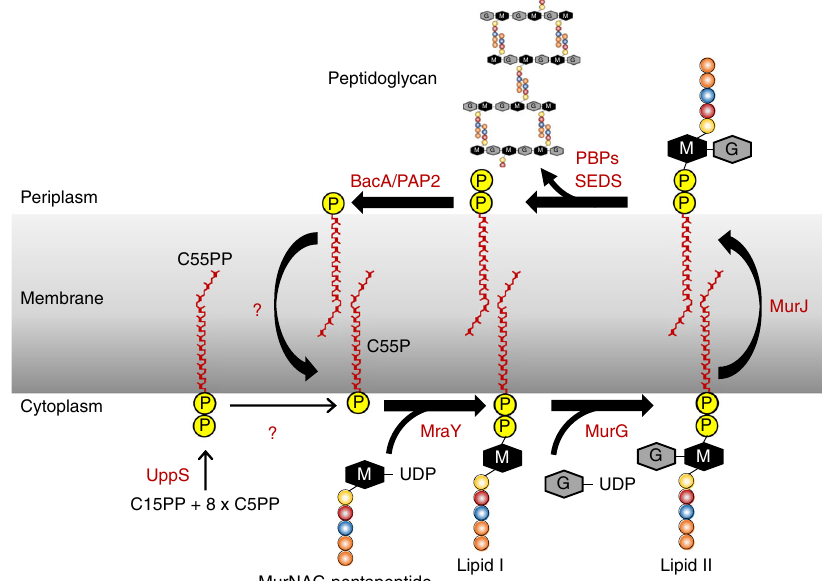
Fig. 1 Peptidoglycan component synthesis (PCS) cycle. Undecaprenyl-pyrophosphate (C55PP) is synthesized by UppS to the cytoplasmic side of the inner membrane. It is dephosphorylated forming undecaprenyl-phosphate (C55P), a glycan subunit carrier, by a pyrophosphatase of unknown